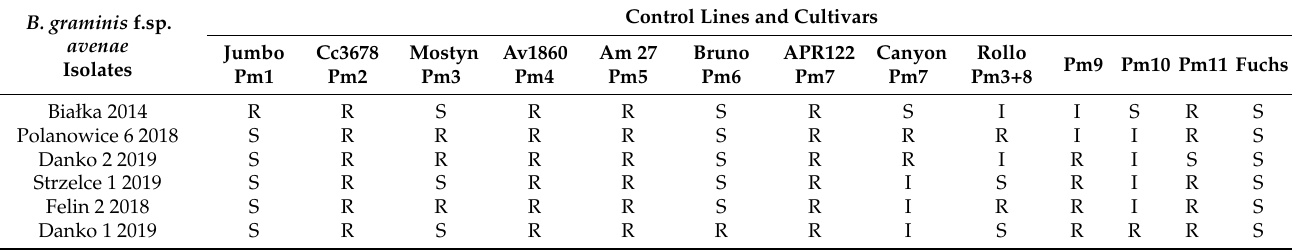
Table 1. Virulence of B. graminis f.sp. avenae isolates chosen for testing A. fatua